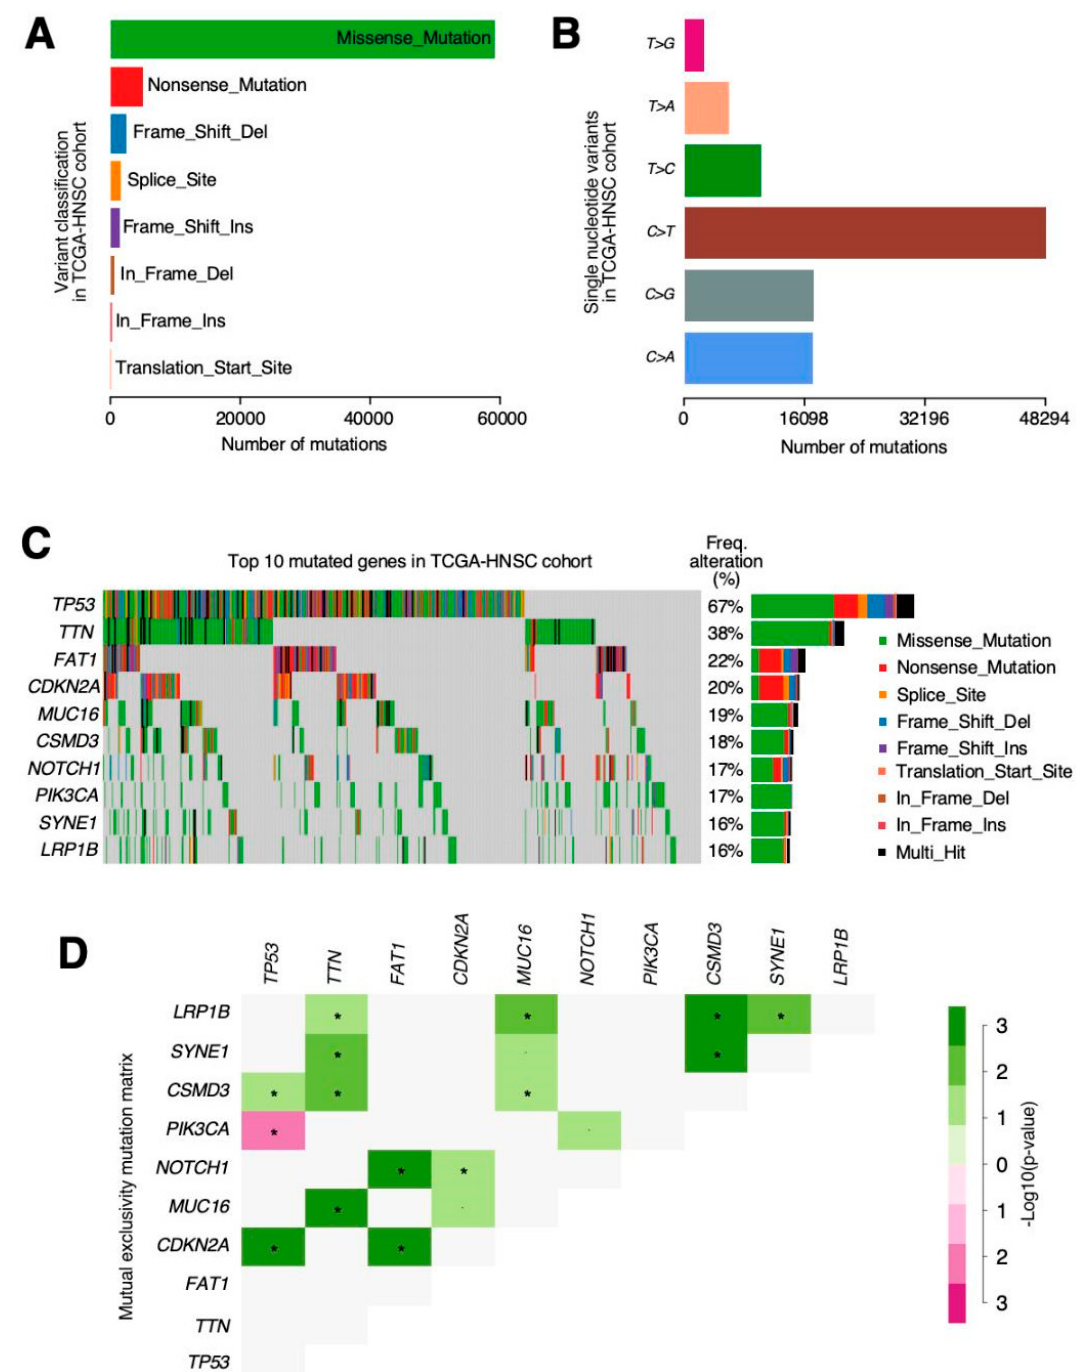
Figure 4. The MuTect2 and VarScan variant caller results are combined in order to facilitate the process of finding every possible alteration in the TCGA-HNSCC cohort. ( A ) Variants show the differences in abundancy across the cohort with missense being the largest represented group. ( B ) Nucleotide changes in single nucleotide variants (SNVs) show the differences in frequency, and the cases in which citosines are substituted by guanosines in the coding DNA strand are more likely to occur. ( C ) Oncoplot showing the top 10 most altered genes. The colours are associated with one class of variant and the percentage (%) of patients affected is shown on the graph. ( D ) Mutation mutual exclusivity matrix heatmap representation. The green colour is associated with a positive correlation whereas red indicates mutual exclusivity. p -value < 0.05 *.